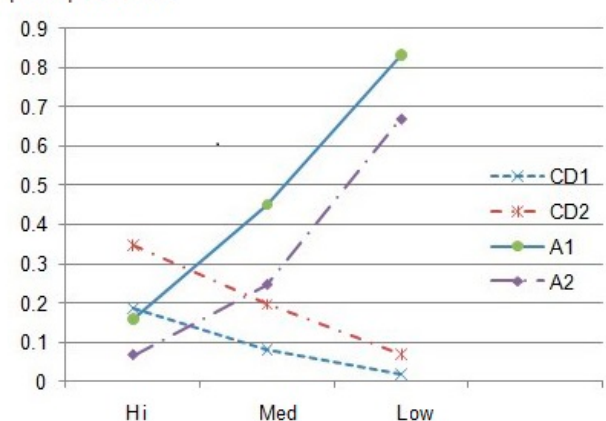
Figure 8. Comparative probabilities of treatment outcome by insurance status and average cost. Notes: CD1—Probabilities of Stopped and Early quit of insured patients; CD2—probabilities of Stopped and Early quit of uninsured patients; A1—probabilities of Complete recovery of insured